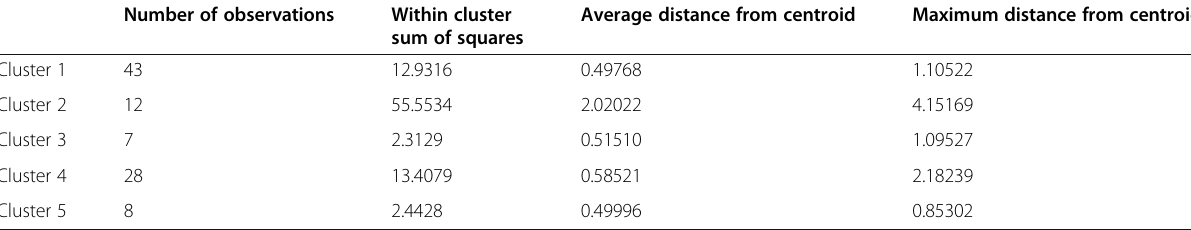
Table 13 Final partition – Optimized network Number of observations Within cluster sum of squares